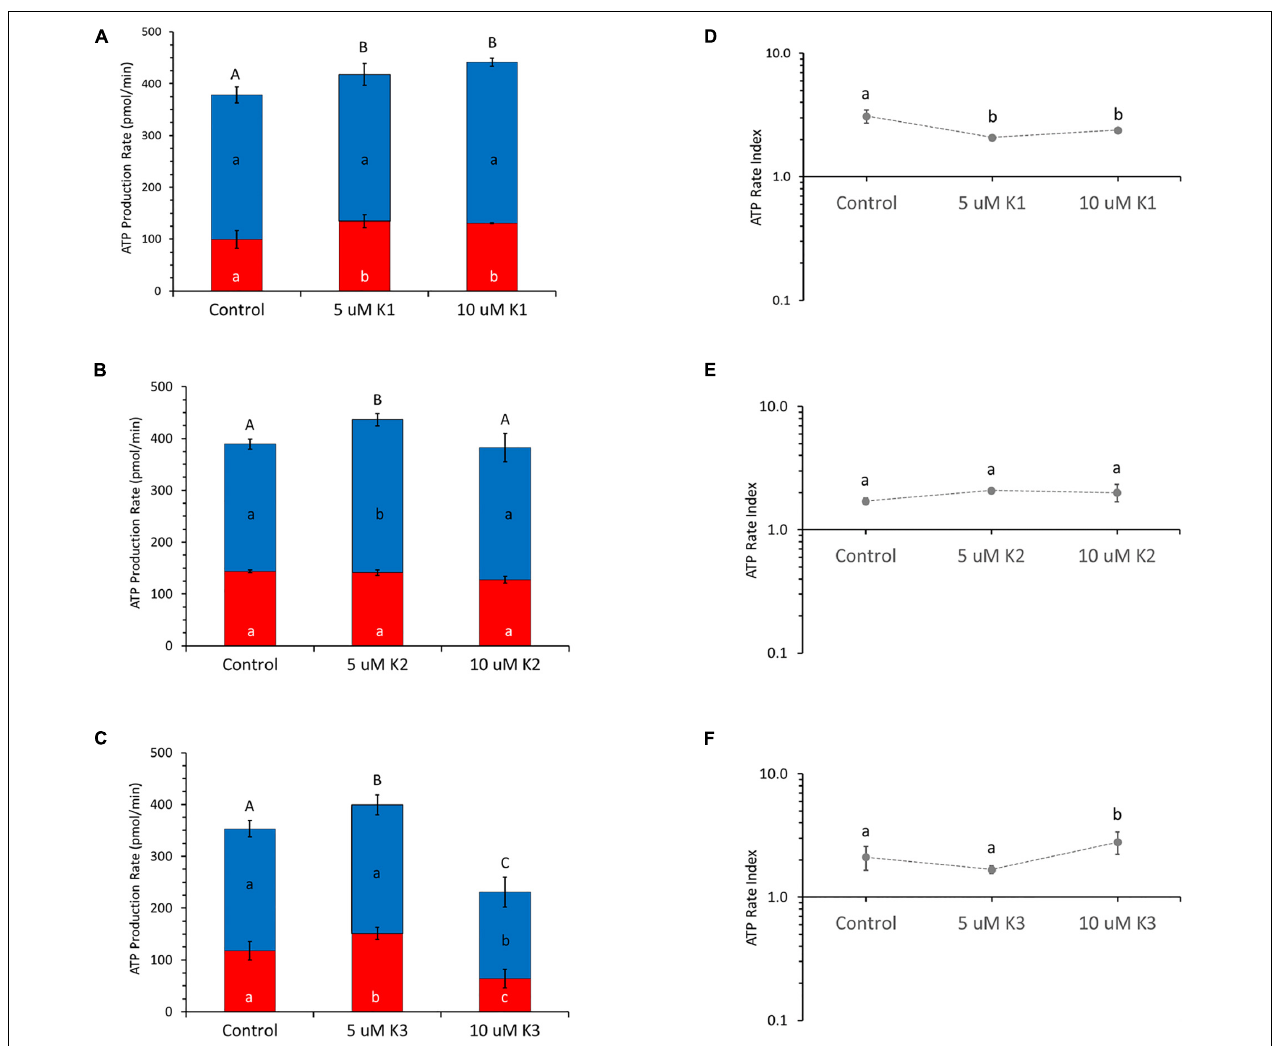
FIGURE 2 | Effect of VKs on the real-time ATP production rate in IPEC-J2 cells. Evaluation of ATP production rate by mitochondrial OXPHOS (blue) ( (cid:4) ) or by glycolysis (red) ( (cid:4) ) in VK1 (A) , VK2 (B) , and VK3 (C) -treated cells. The ATP rate index, calculated as the ratio between the mitochondrial ATP production rate and the glycolytic ATP production rate, is shown on the y-axis (logarithmic scale) in IPEC-J2 treated with 0 (Control), 5, and 10 µ M VK1 (D) , VK2 (E) , and VK3 (F) . Data, expressed as column chart [ (A,B,C) plots] and points [ (D,E,F) plots], represent the mean ± SD (vertical bars) from three experiments carried out on distinct cell preparations. Different lower-case letters indicate significantly different values ( P ≤ 0 . 05 ) among treatments (0, 5, 10 µ M) in the same metabolic pathway; different upper-case letters indicate different values ( P ≤ 0 . 05 ) among treatments in ATP production rates due to sum of OXPHOS plus